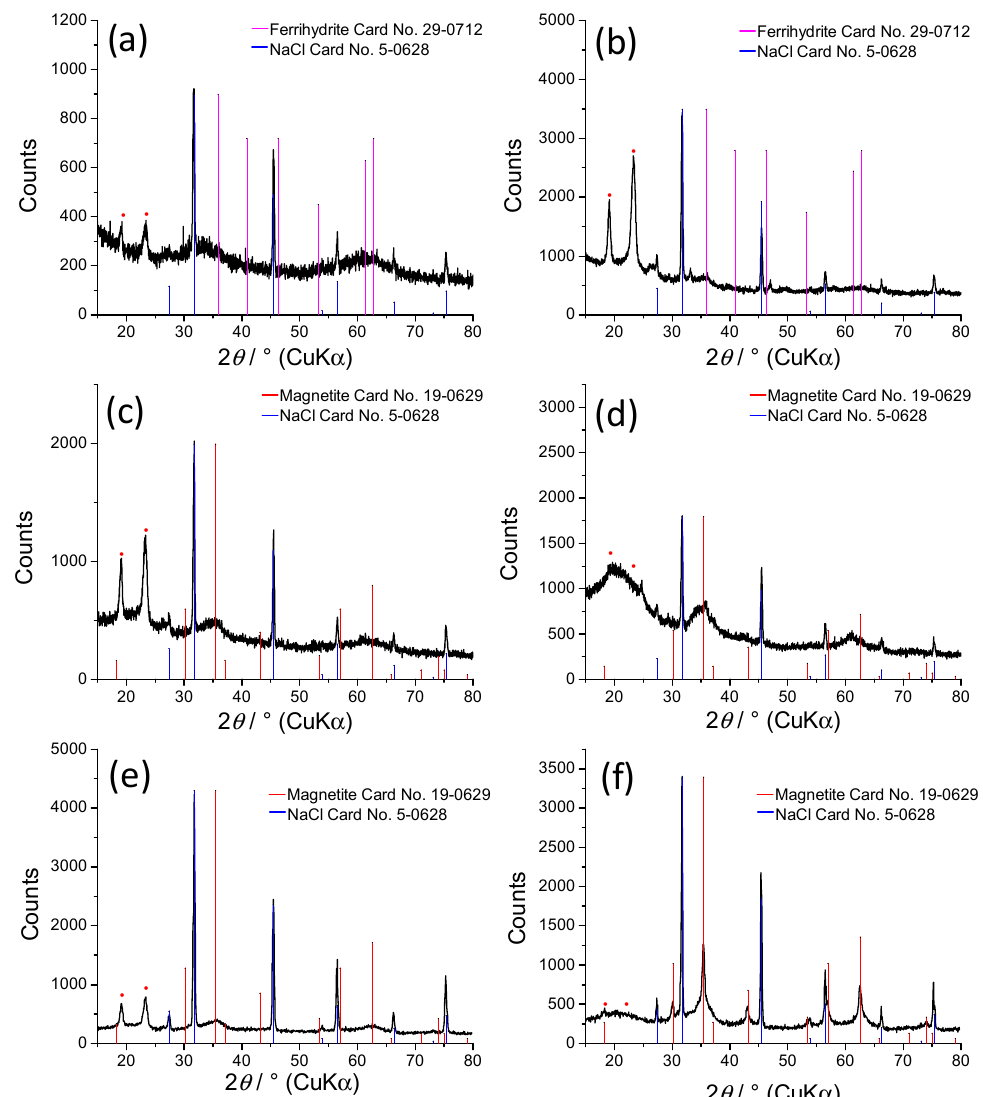
Figure 6. XRD patterns of unirradiated precursor ( a ) and PEO / Fe-oxide gels obtained from suspensions with: 5 wt% Fe 3 + at 50 kGy ( b ), 5 wt% Fe 3 + at 130 kGy ( c ), 5 wt% Fe 3 + at 300 kGy ( d ) 20 wt% Fe 3 + at 130 kGy ( e ) and 20 wt% Fe 3 + at 300 kGy ( f ), at pH ~ 12. The two maxima at ~19 and ~23 degrees marked with red dots correspond to crystalline